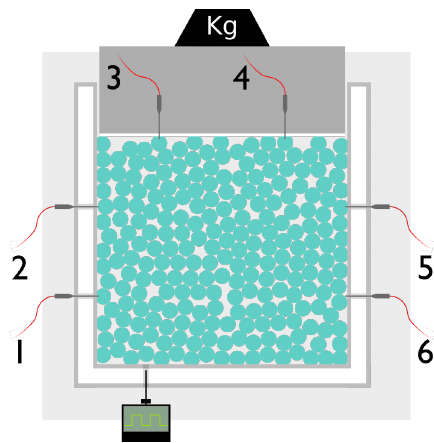
Figure 1. Schematic of the experimental setup. Grains are ar- ranged in a 2D layer held by a (cid:116) shape made of insulating foam. Constant pressure is applied on the top and acoustic signals are recorded by 6 peripheral sensors. Artificial waves are created by a shaker, hitting one grain with a metallic pin, driven with a square